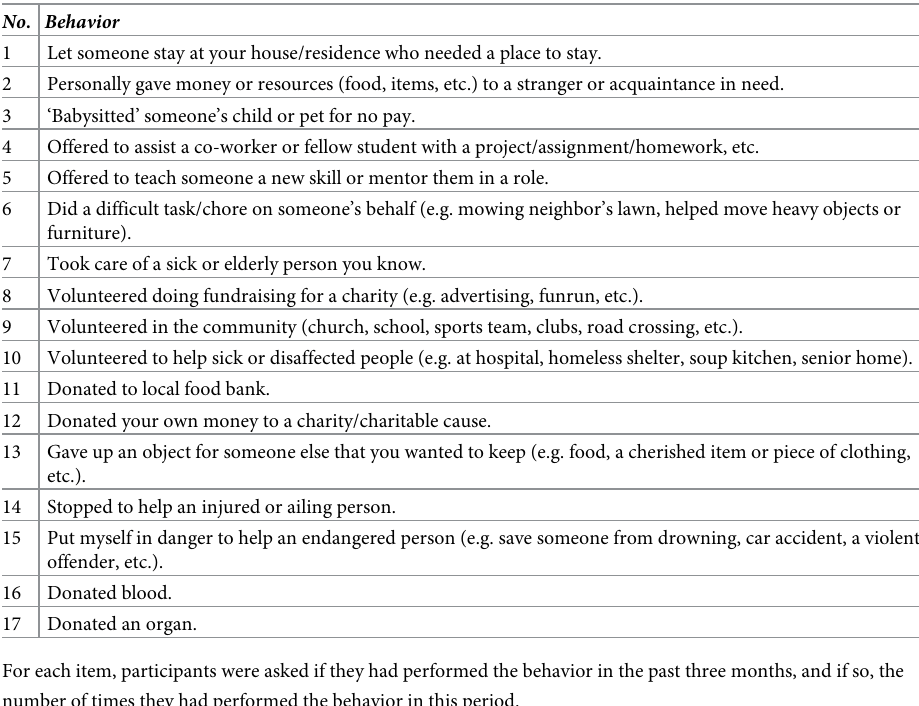
Table 9. Prosociality inventory in Study